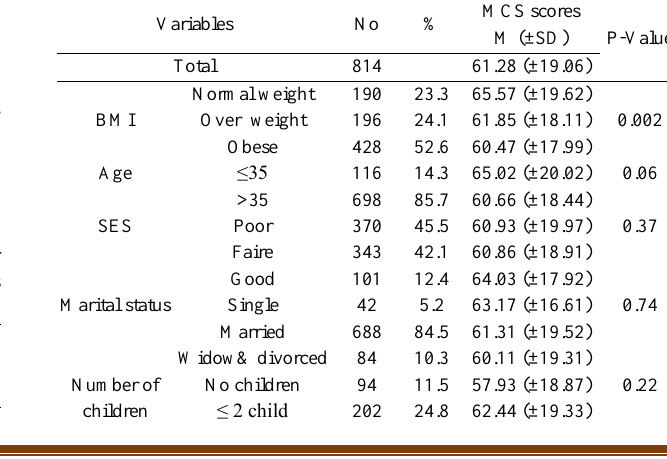
Figure1 : Prevalence of obesity as compared to overweight